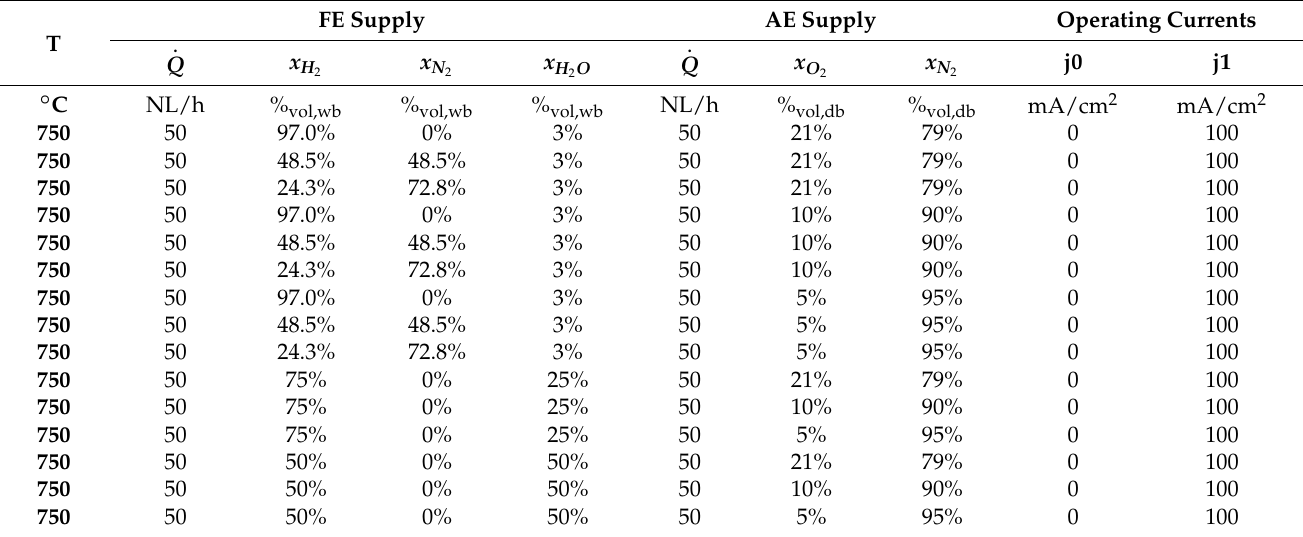
Table 2. Design of experiments—part 1 “electrode feeding gas